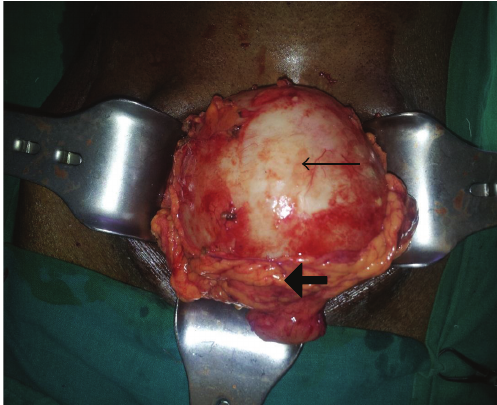
Figure 2: Omental hydatid cyst (thick arrow showing omentum, thin arrow showing hydatid